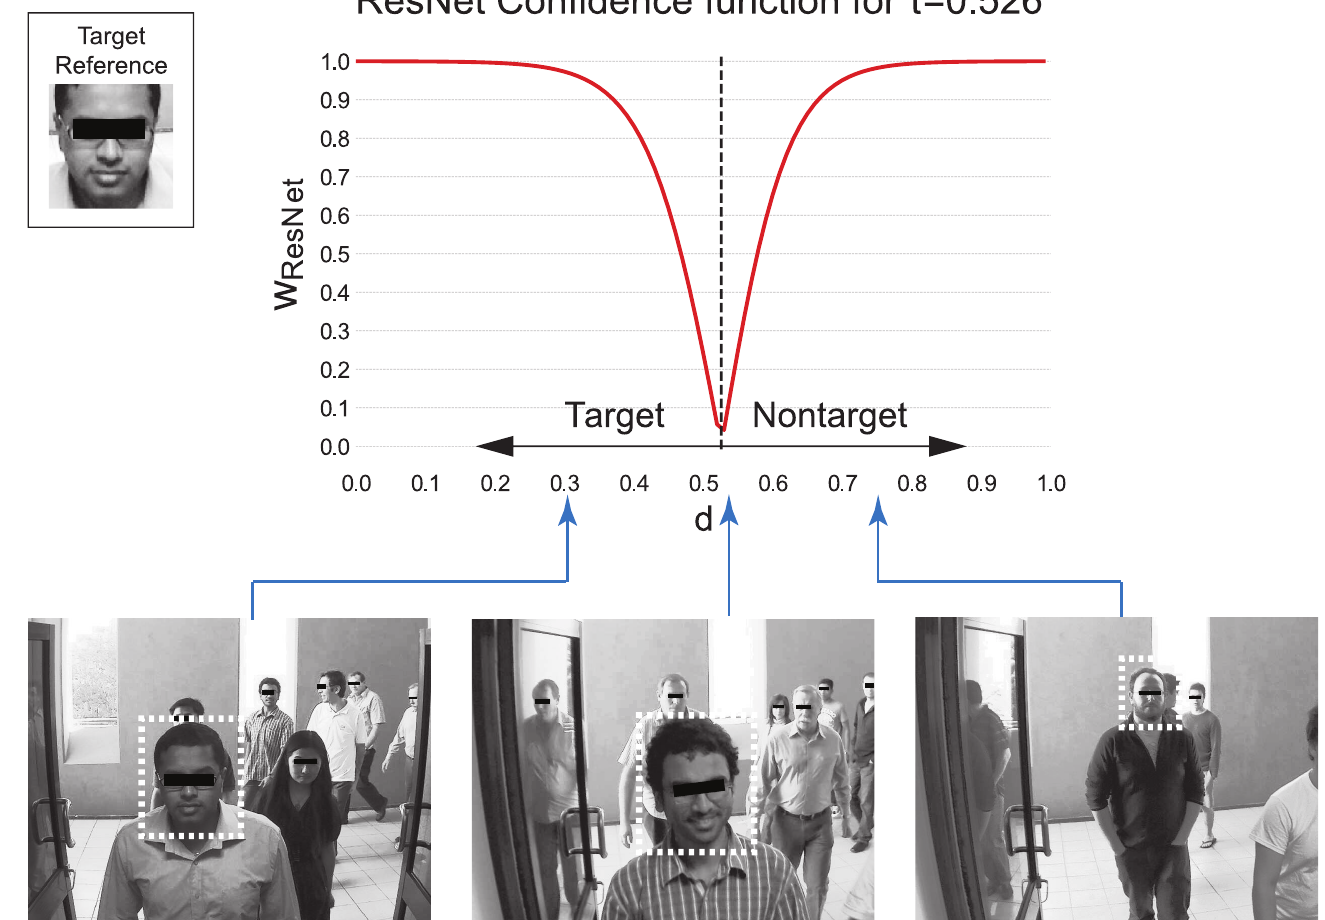
Fig 2. Function used with the ResNet to transform the difference between the encodings of the stimulus and target faces, d , into confidence weights for the average value of the threshold t over the eight folds. Examples of stimuli with d = 0.301 (left), d = 0.535 (middle), and d = 0.750 (right) are also shown at the bottom. In each image, the bounding box of the face with the minimum d is highlighted. The reference image of the target person is shown on the top left. Images representing people have been blurred for publication requirements.